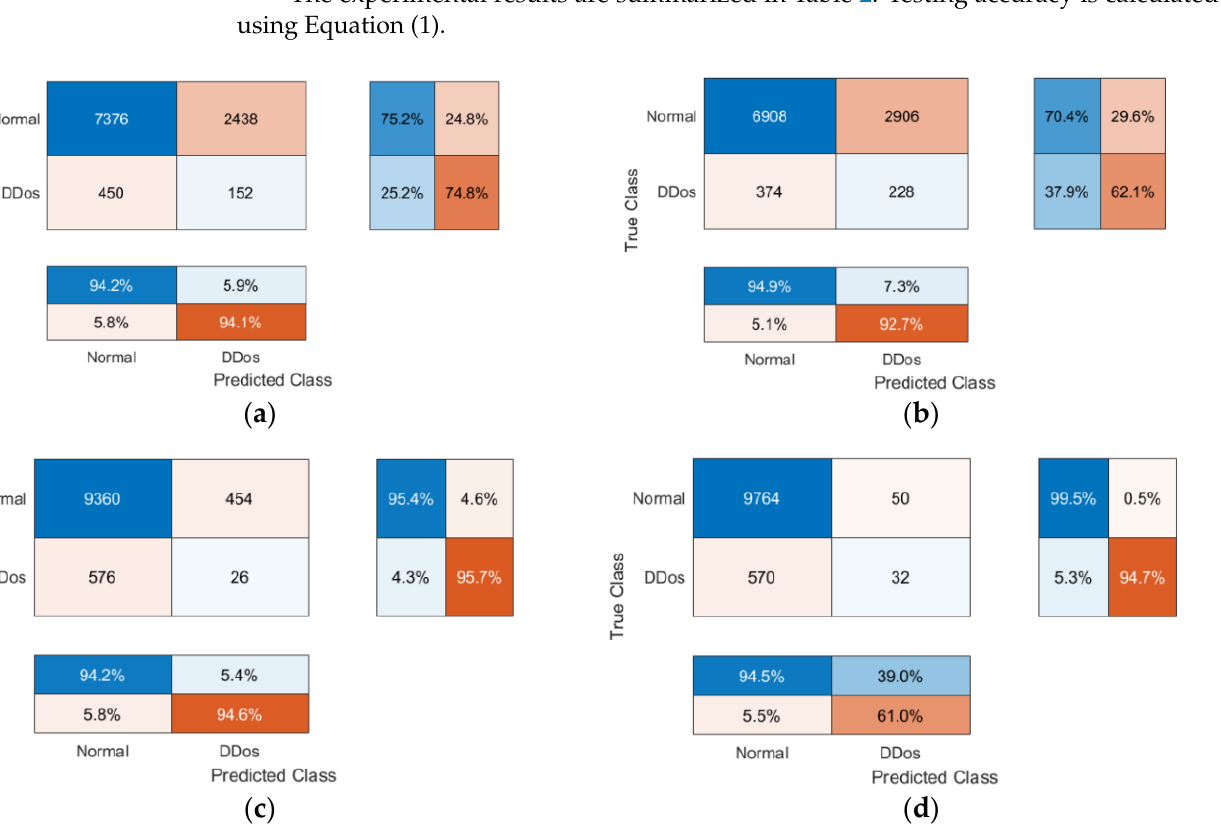
Figure 10. Confusion matrix visualizing the performance of TTL with ResNet50 architecture to train the Global Model.